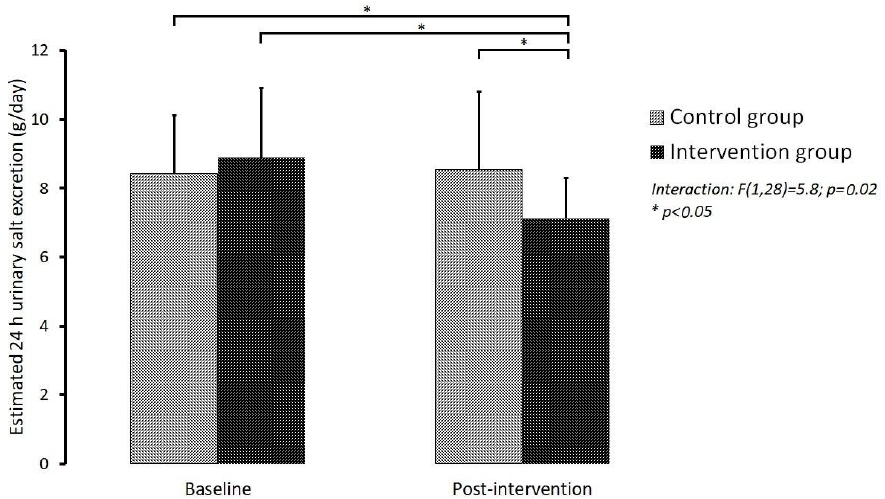
Figure 3. Comparison of daily saline excretion between groups at the two assessment times (moment 1: pre-intervention; moment 2: post-intervention).